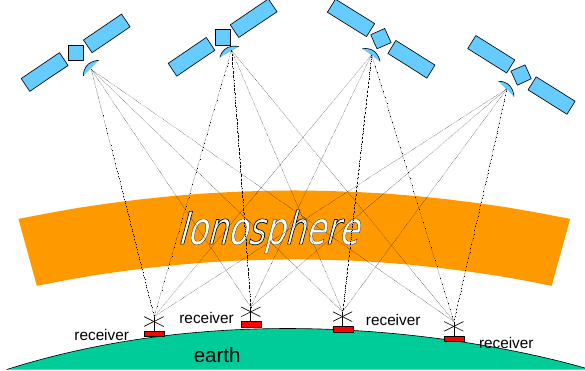
Fig. 1. Configuration with TEC measurements for ionospheric to- mography.